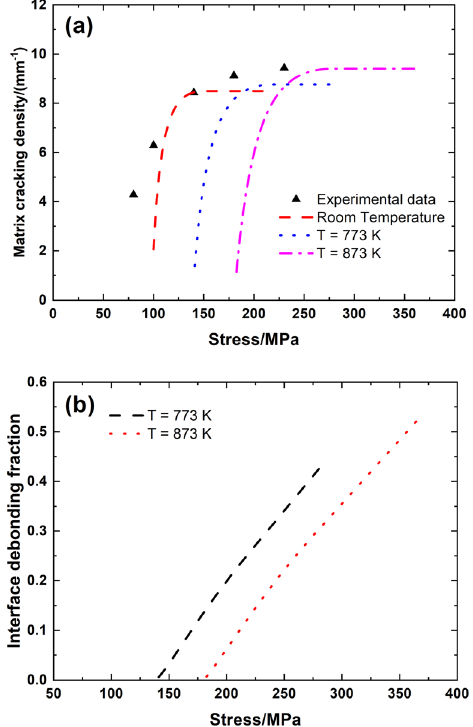
Figure 4: ( a ) The experimental and theoretical matrix multicracking density versus applied stress curves and ( b ) the interface debonding fraction versus applied stress curves of unidirectional C/SiC